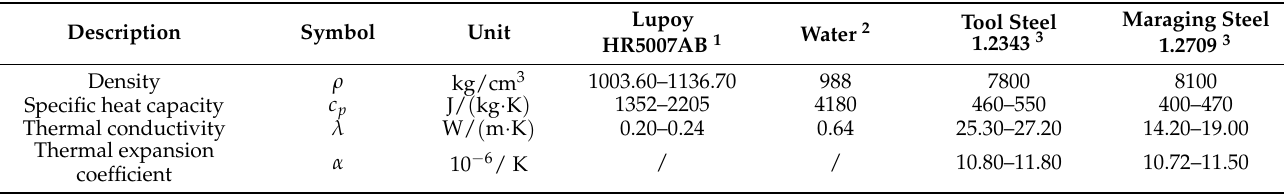
Table 2. Thermal properties of the materials used.